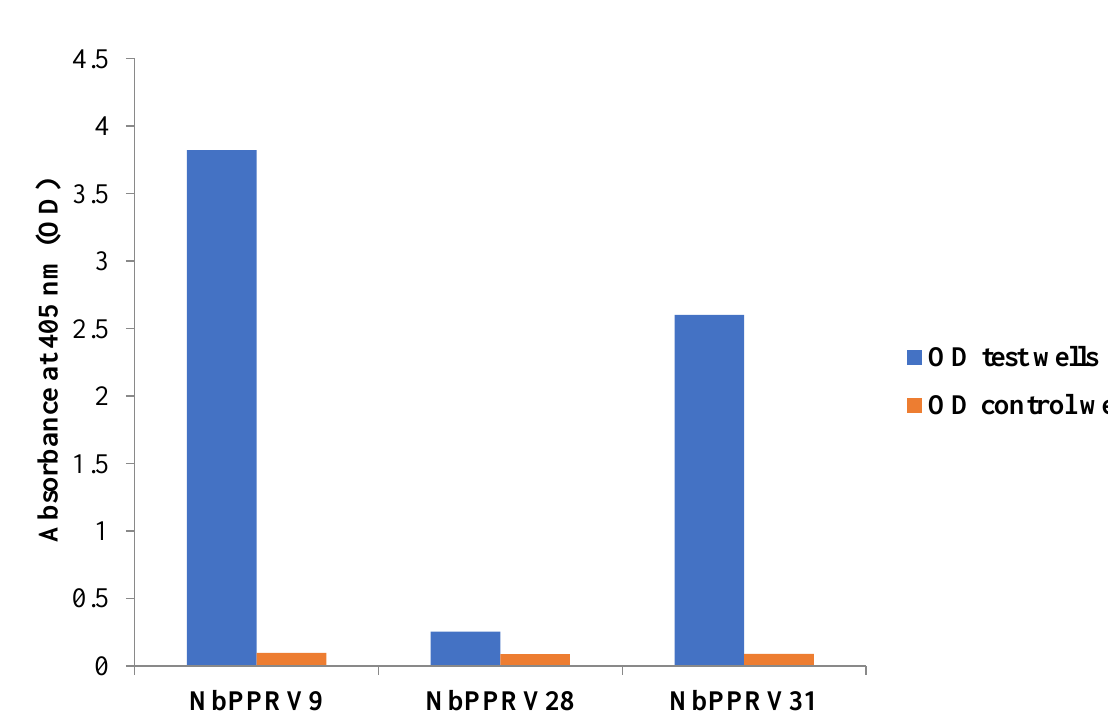
Figure 1. Alignment of single domain antibody sequences of three nanobody families that recognise peste des petits ru- minants virus antigens in enzyme-linked immunosorbent assay based on complementarity determining regions (CDRs) of nanobody.